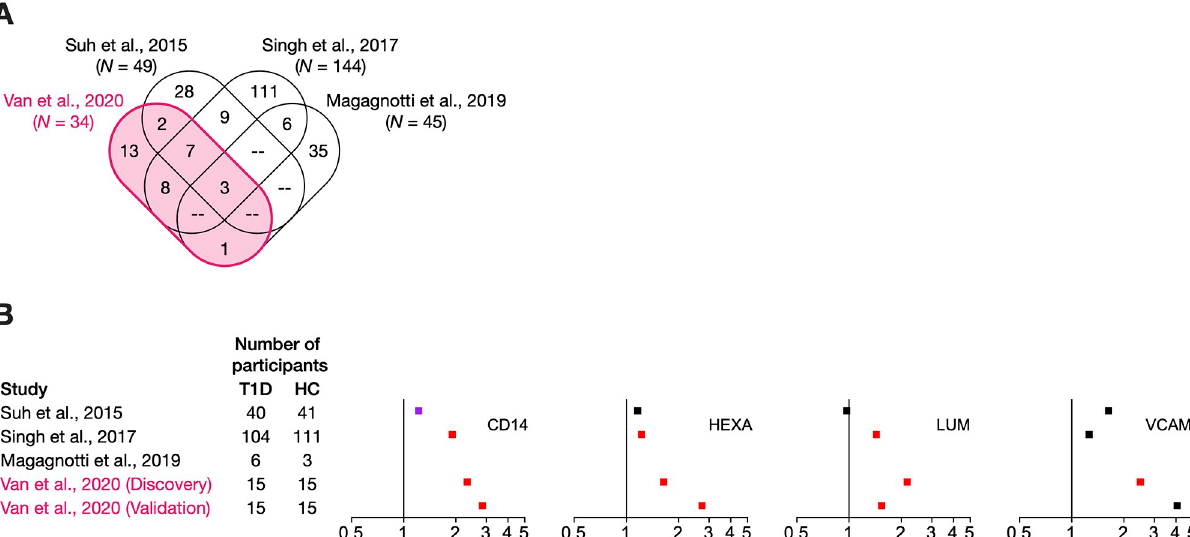
Fig 5. Comparison of current findings with the literature. (A) Venn diagram of the urinary signature proteins from our current study (highlighted in red) and three other proteomic studies of early diabetes. Signature proteins were defined on the basis of statistical significance after Benjamini-Hochberg adjustment ( Q < 0.05) for three studies [24, 25], including our analysis, or on the basis of a combination of factors (|fold change| > 1.6, P < 0.06) for the study by Magagnotti and colleagues [26]. (B) Forest plots of fold changes of urinary excretion of the four proteins selected for validation. Fold change is calculated as a ratio of the median excretion of youths with diabetes to that of youths without diabetes. Colours delineate proteins that belong to the urinary signature of the indicated study (red, Q < 0.05); proteins that were differentially excreted but lost statistical significance after Benjamini- Hochberg adjustment (purple, P < 0.05); and proteins that failed to reach statistical significance before and after adjustment (black, P � 0.05). CD14, monocyte differentiation antigen CD14; HEXA, beta-hexosaminidase subunit alpha; HC, non-diabetic youths; LUM, lumican; T1D, youths with type 1 diabetes; VCAM-1, vascular adhesion